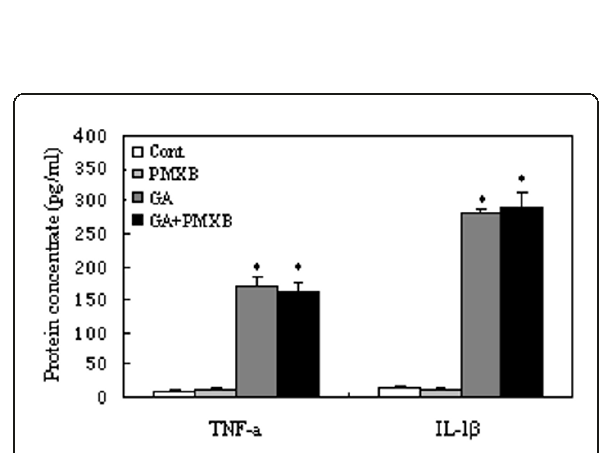
Figure 4 Effect of the endotoxin-binding polypeptide polymyxin B (PMXB) on cytokine production by microglia stimulated with glycated albumin (GA) for 24 h . Neither TNF-